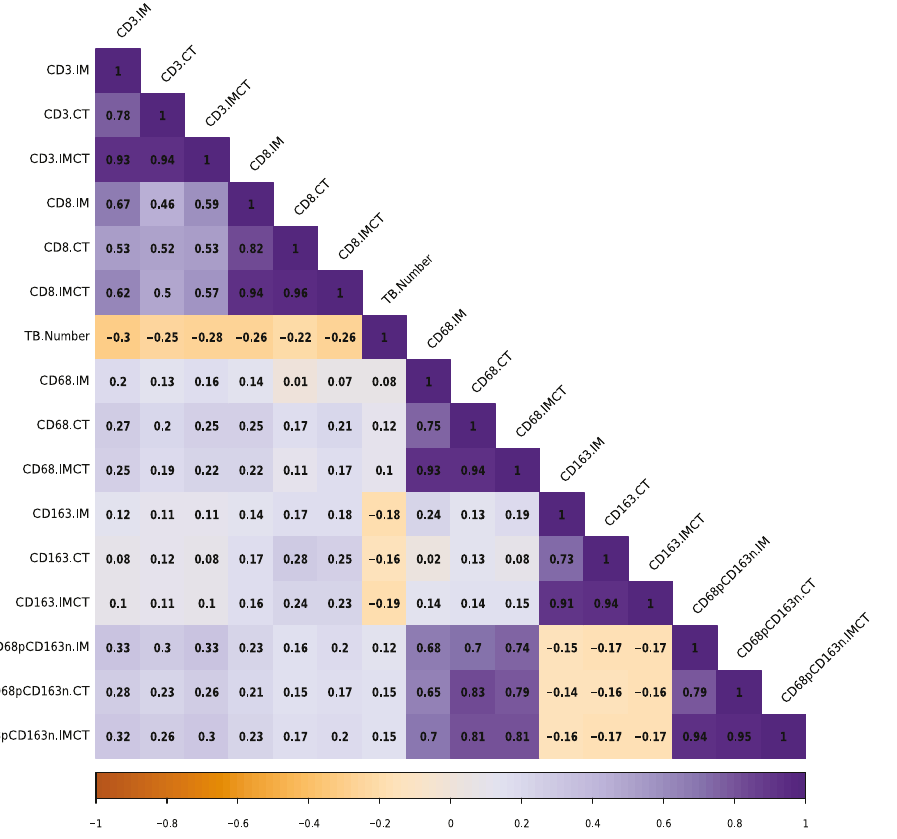
Fig. 3 Spearman correlation matrix for macrophages, lymphocytes, and TBs. A correlation coef fi cient is shown for each relationship. A greater than 0 coef fi cient is shown in purple and indicates a positive association, a less than 0 coef fi cient is shown in orange and indicates a negative association. Table 2. LASSO penalized Cox regression and Random Forest Gini coef fi cients for the signi fi cant features.